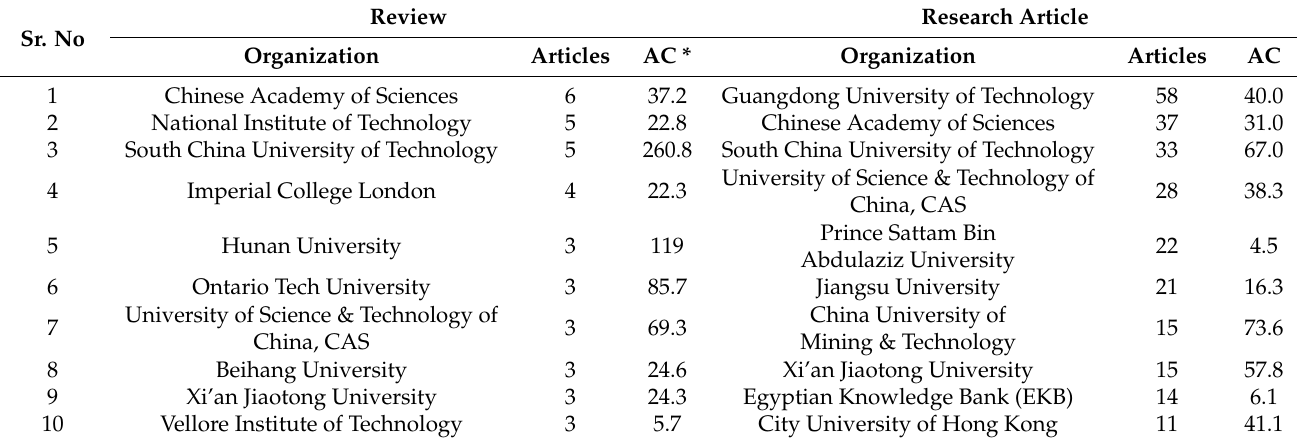
Table 3. Top 10 institutions with more publications.